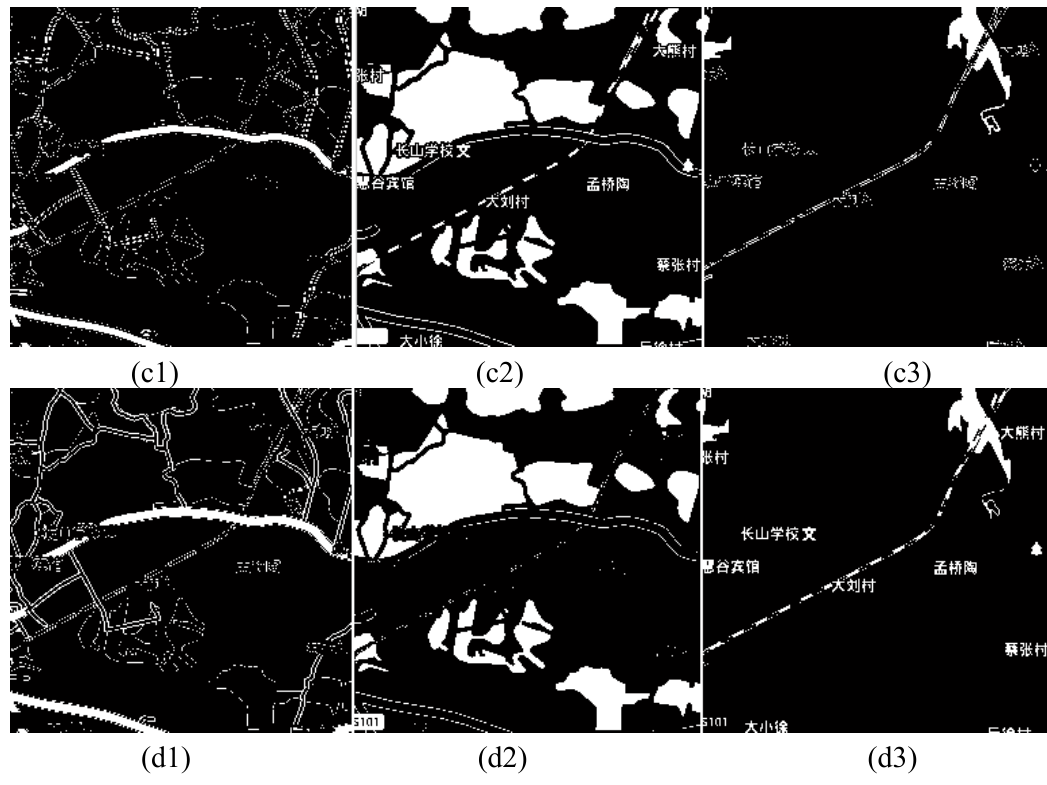
Figure 4. The segmentation result of “map2” image: (a) “map2” original image; (b1) “road” of KFCM_F; (b2) “lake” of KFCM_F; (c1) “road” of FCM_S; (c2) “terrain” of FCM_S; (c3) “lake” of FCM_S; (d1) “road” of the proposed method; (d2) “terrain” of the proposed method; (d3) “lake” of the proposed